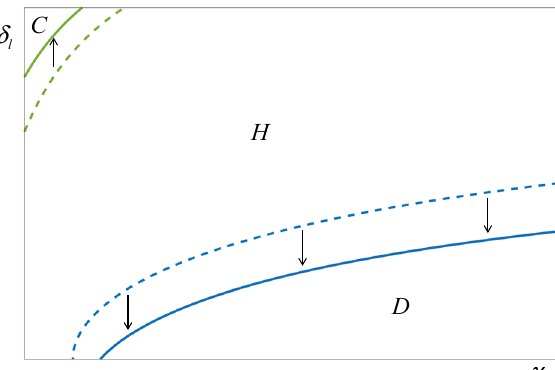
Fig. 8 Linking liquidation costs to supervisory responsabilities where x ∗ = x ( e ∗